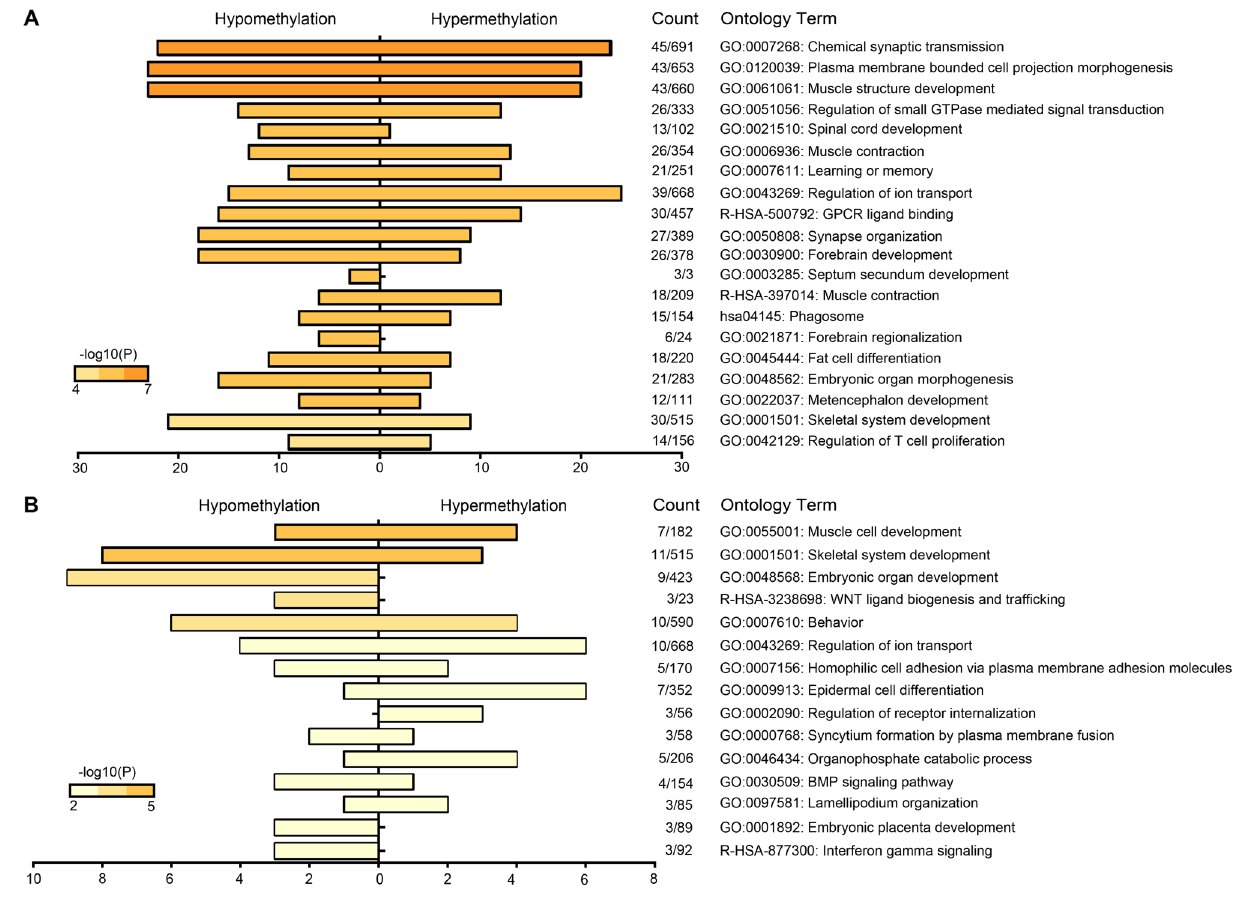
Figure 4. Pathway analysis of age-associated sperm DMRs. ( A ) FDR-adjusted DMRs (n = 1146) and ( B ) Bonferroni-adjusted DMRs (n = 156).